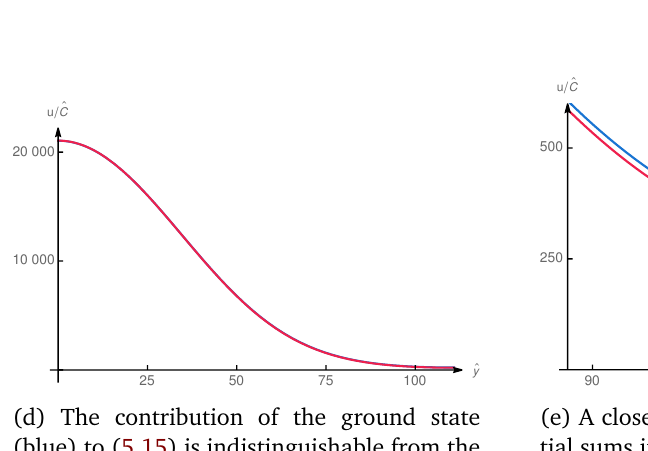
tial sums in panel (d). = ˆ (cid:96)/ 2, DF , and the c decreases its c